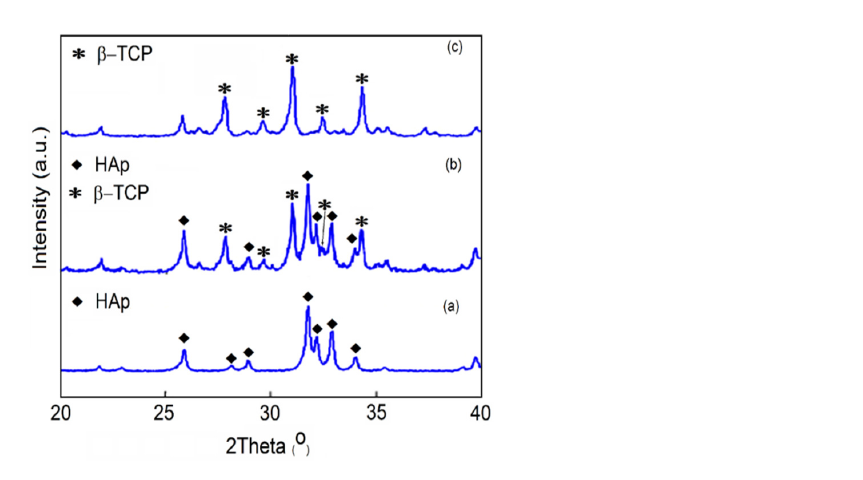
Figure 3. Time averaged attenuation for the 1000 samples in the selected frequency range.